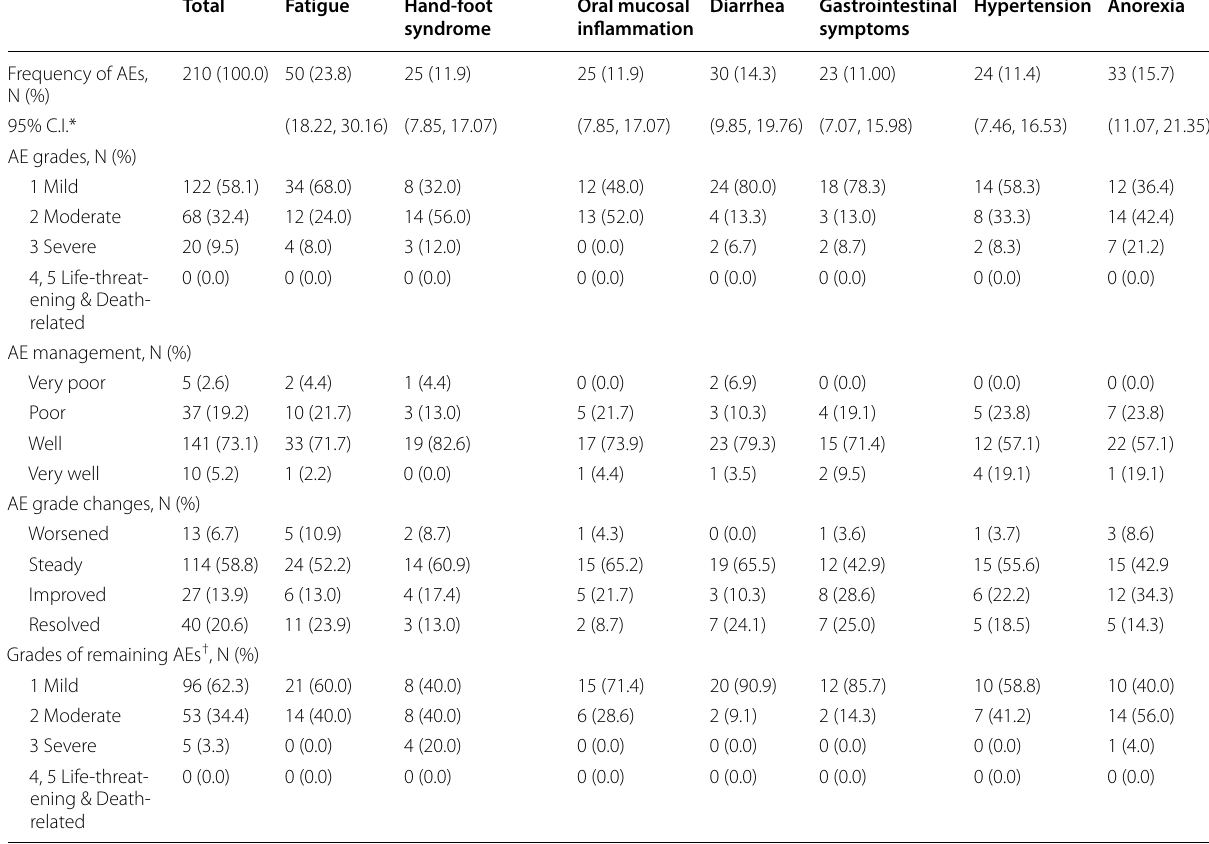
Table 3 Adverse events and patients’